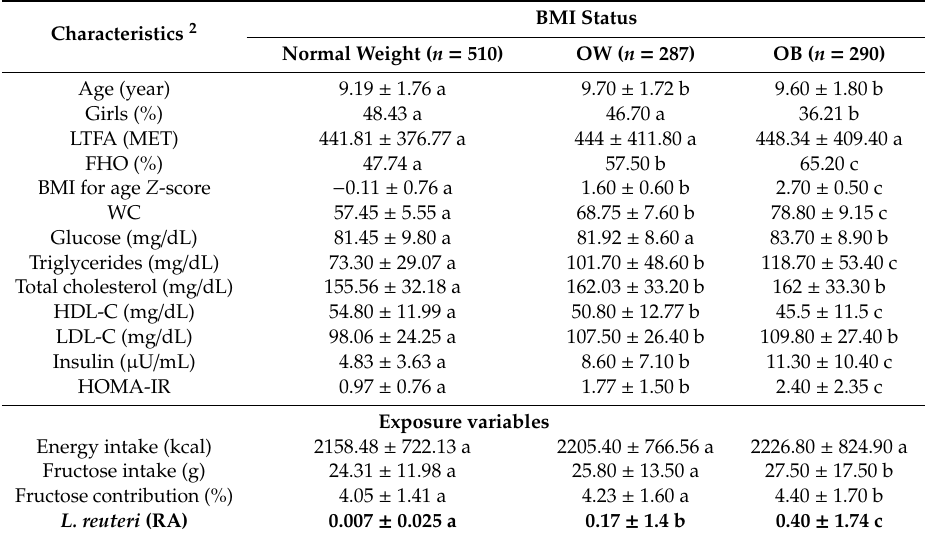
Table 1. General characteristics by BMI status of children from Mexico City 1